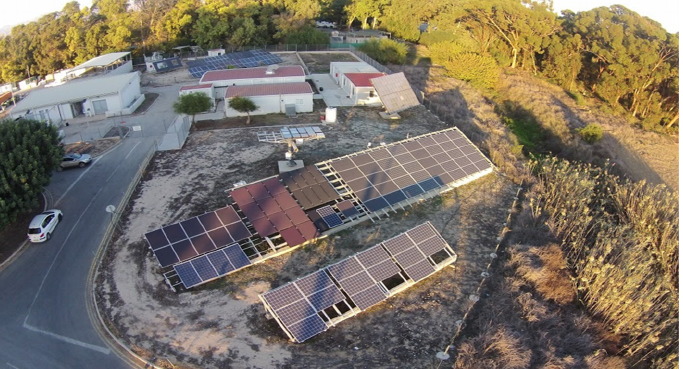
Figure 9. Aerial view of the PVTL,